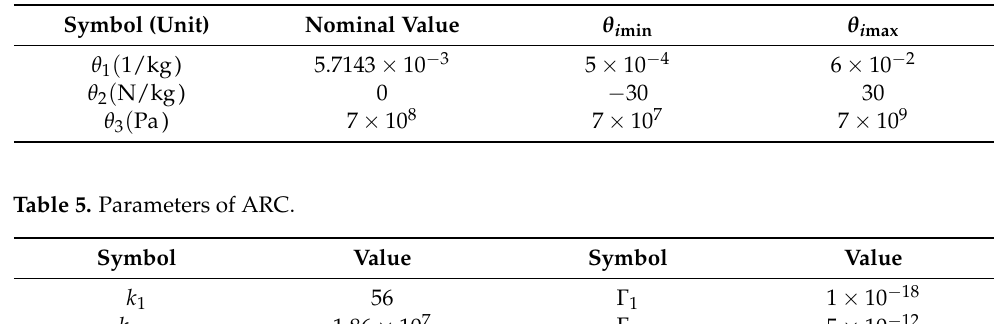
Table 4. Nominal Values and bounds of θ i .